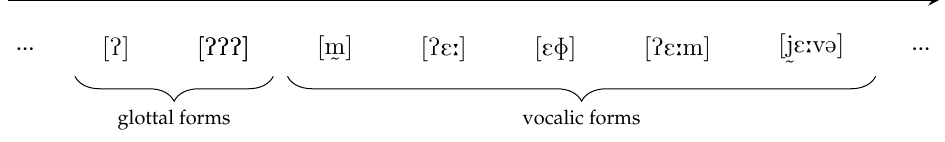
Figure 15. Continuum of phonetic forms of filler particles with German examples from the Berlin Dialogue